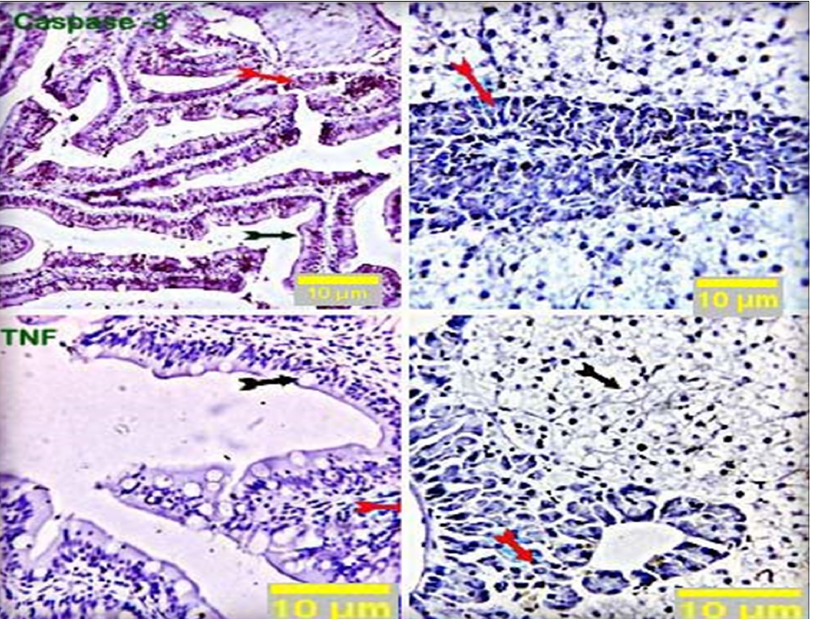
Figure 5. Stained sections of the intestine and liver of the control group showed negative staining reactions in all the examined parts of the intestinal and hepatic tissue (black and red arrows) against caspase-3 and TNF- α antibodies. Nearly 10% of hepatic portal cells reacted positively to caspase-3. Scale bars = 10 µm.